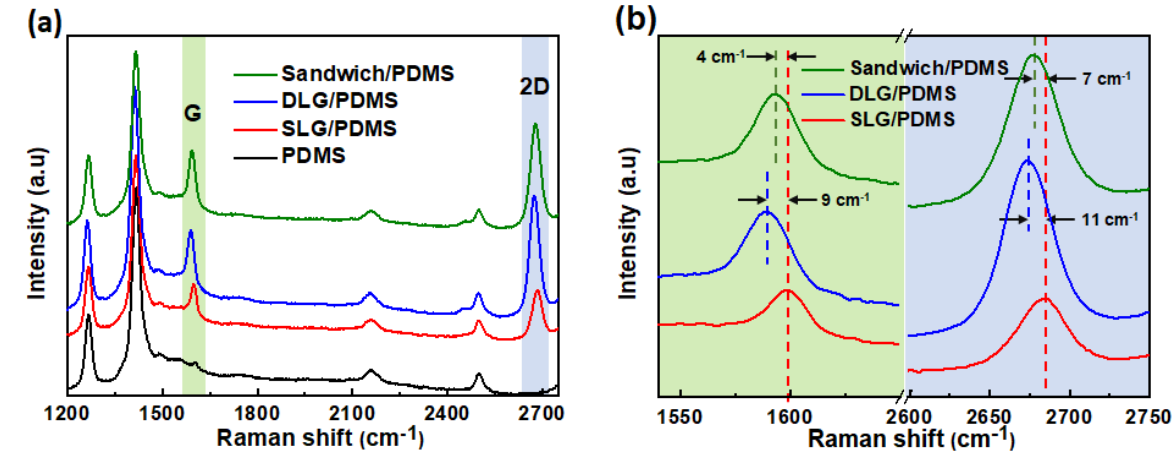
Figure 2 . ( a ) Raman spectra of pristine PDMS, SLG/PDMS, DLG/PDMS and sandwich/PDMS samples; ( b ) enlargement of 2D peaks of SLG/PDMS, DLG/PDMS and sandwich/PDMS.